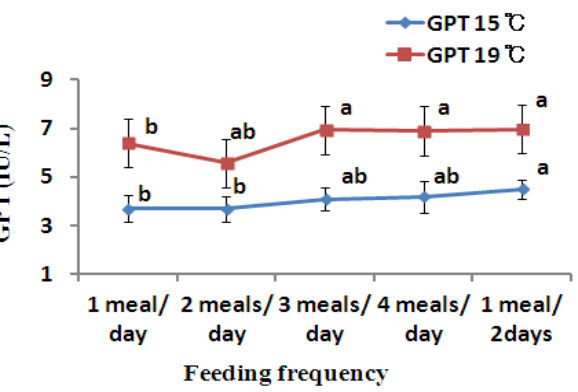
Figure 3. Glutamic pyruvic transaminase of rockfish with different feeding frequencies at 15°C and 19°C.